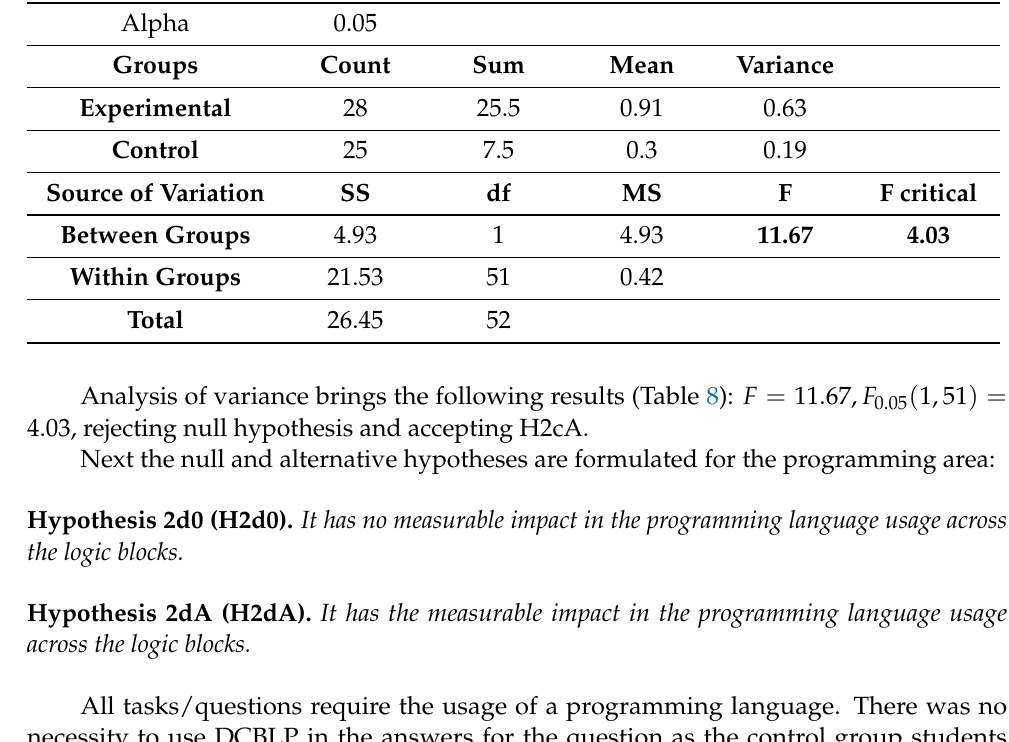
Table 8. ANOVA (single factor) results for the Sequential block achievement tests comparison.